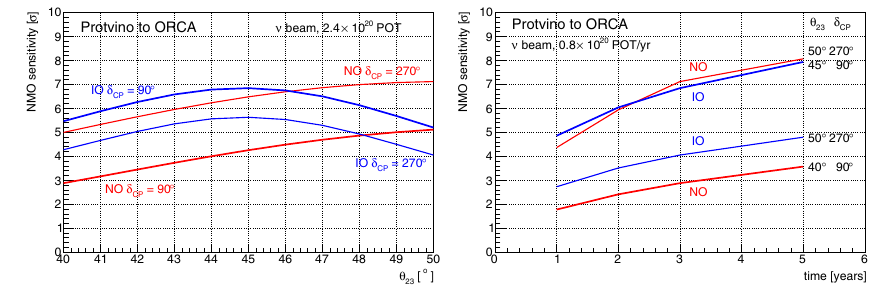
ν Figure 2. Left : Oscillation probabilities for ν µ Figure 3. Sensitivity of P2O to neutrino mass ordering (NMO). Left: NMO sensitivity as a function of e (electron neutrino appearance) for baseline L = → 2595 km for normal (red) and inverted (blue) mass ordering. Right : The e ff ect of the CP phase on the the θ 23 mixing angle after 3 yr of running with a 90 kW beam. Right : NMO sensitivity as a function of expected number of neutrino events that would be detected by ORCA for 2 . 4 10 20 POT. The case of the accumulated exposure time with the 90 kW beam. The θ 23 and δ CP values chosen provide the most · normal neutrino mass ordering with θ 23 = 45 ◦ has been assumed. The x-axis shows the true neutrino and the least favorable scenarios for both normal and inverted energy.